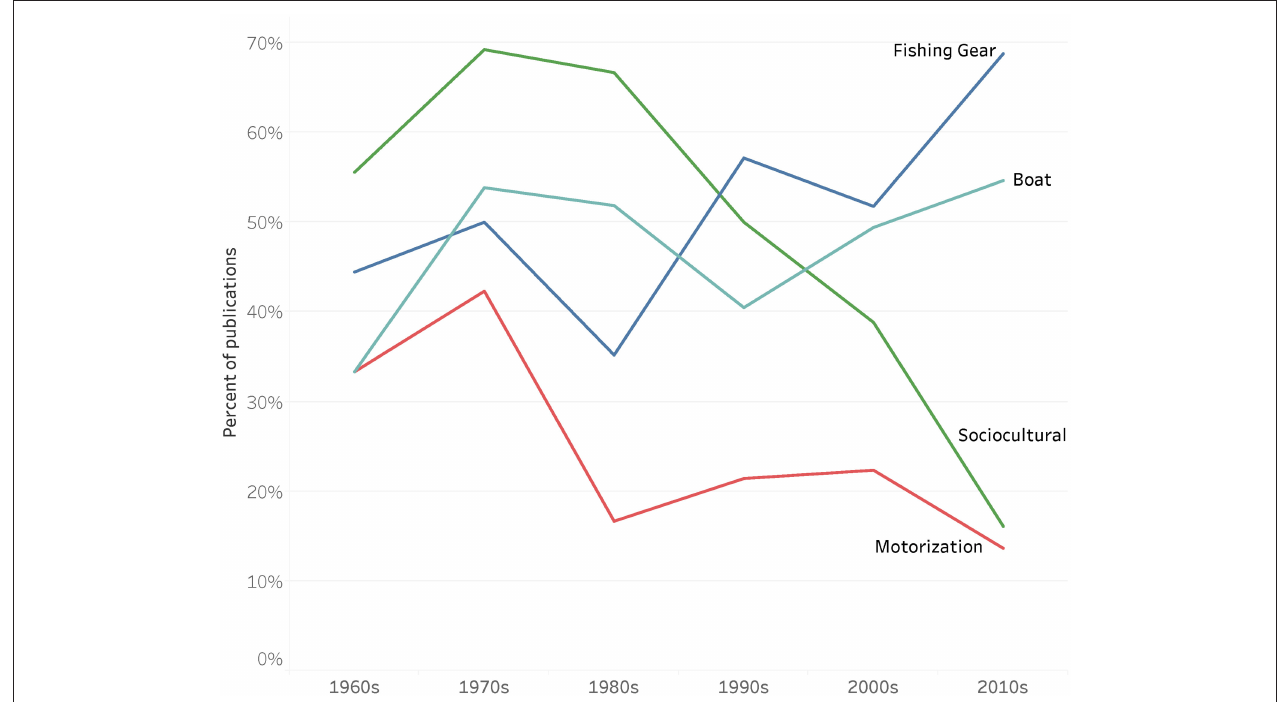
FIGURE 5 | The percentage of articles that defined SSF by different dimensions and decade. Only technological dimensions and sociocultural dimensions were